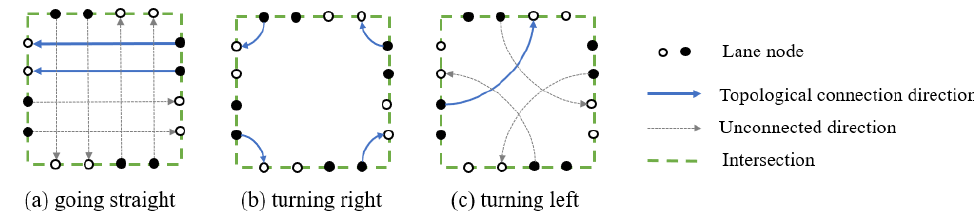
Figure 2. Lane-level topology